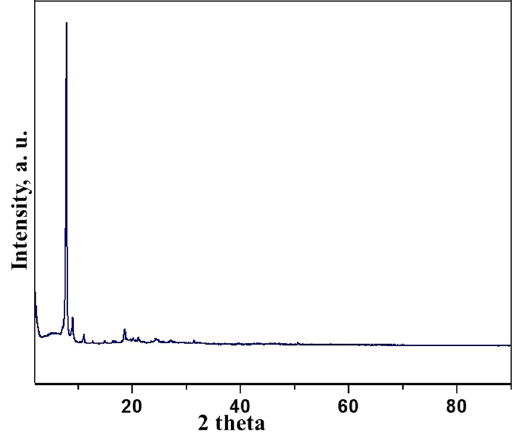
Figure 2. XRD analysis of Ti-ZTBF.